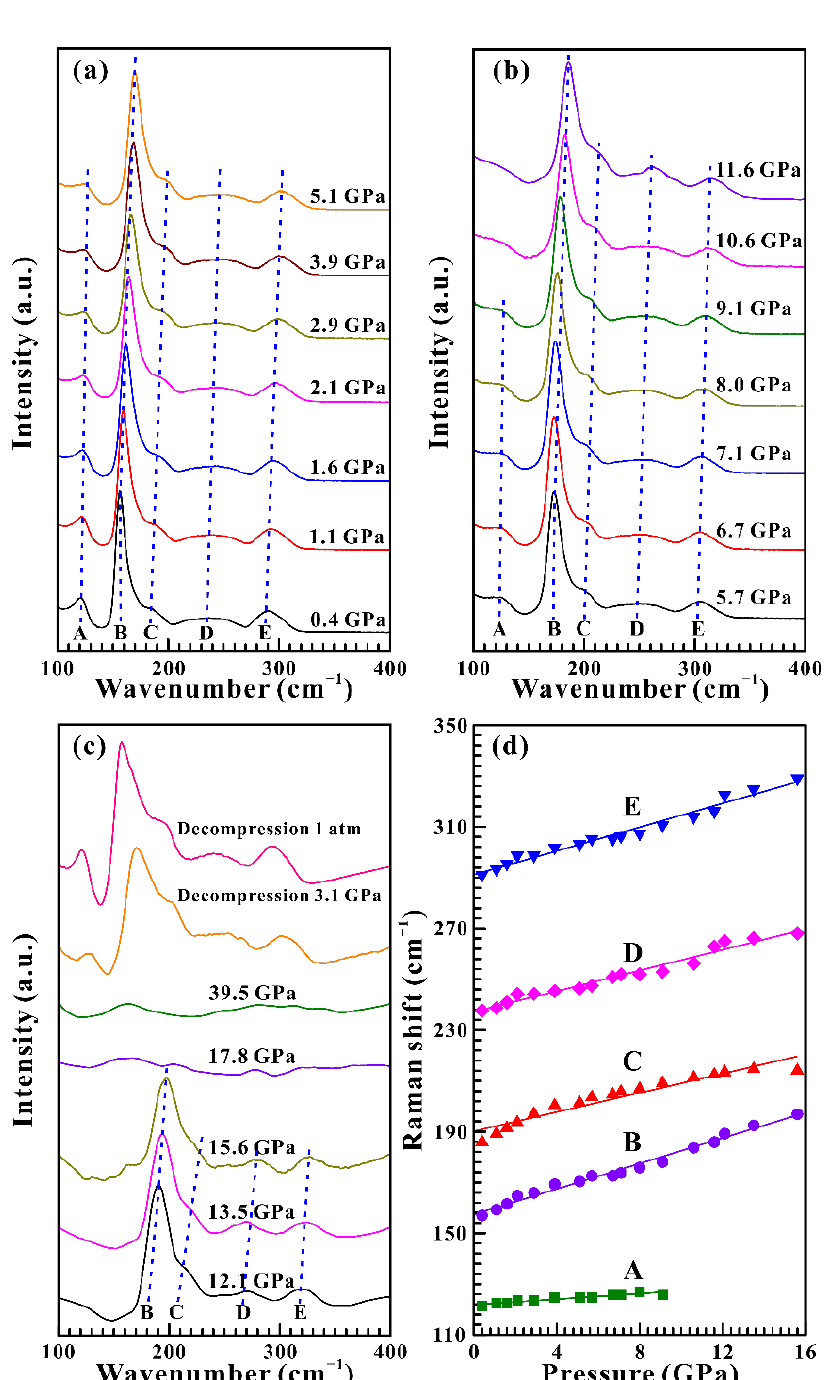
Figure 2. ( a – c ) Raman spectra of Ga 2 Se 3 at the pressure range of 0.4–39.5 GPa during compression, and the Raman spectra at the pressure points of 3.1 GPa and 1atm during decompression; ( d ) Pressure dependence of Raman shifts for Ga 2 Se 3 under non-hydrostatic conditions. In here, the A, B, C, D and E modes referred to the Raman-active peaks at 121.3, 157.0, 185.9, 237.6, and 291.1 cm − 1 obtained at 0.4 GPa, respectively.